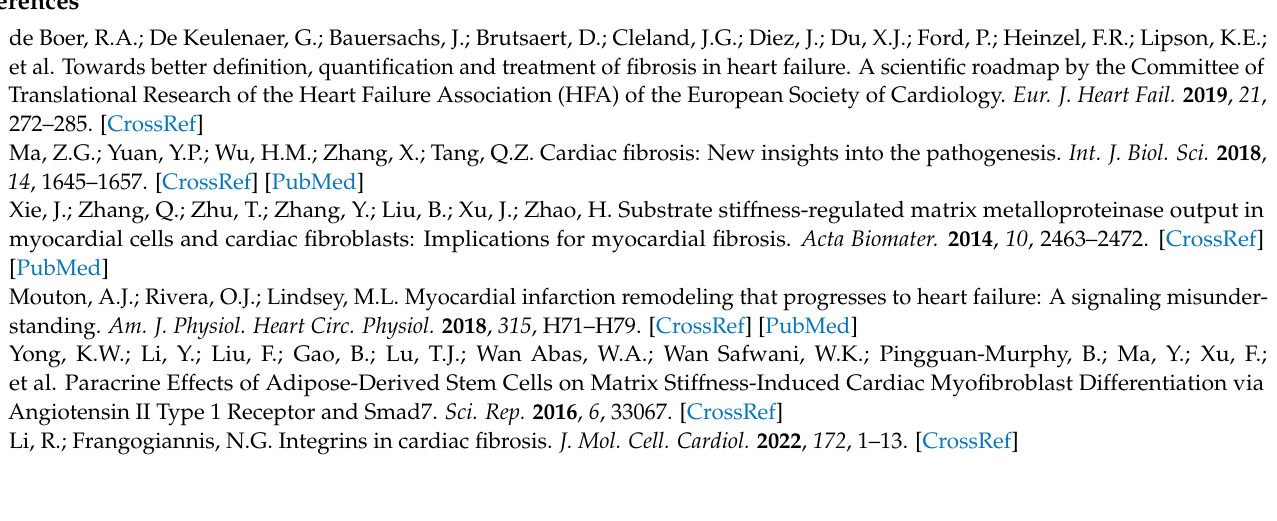
Figure S6: Schematic diagram of SECM simulation model. S4. Experimental